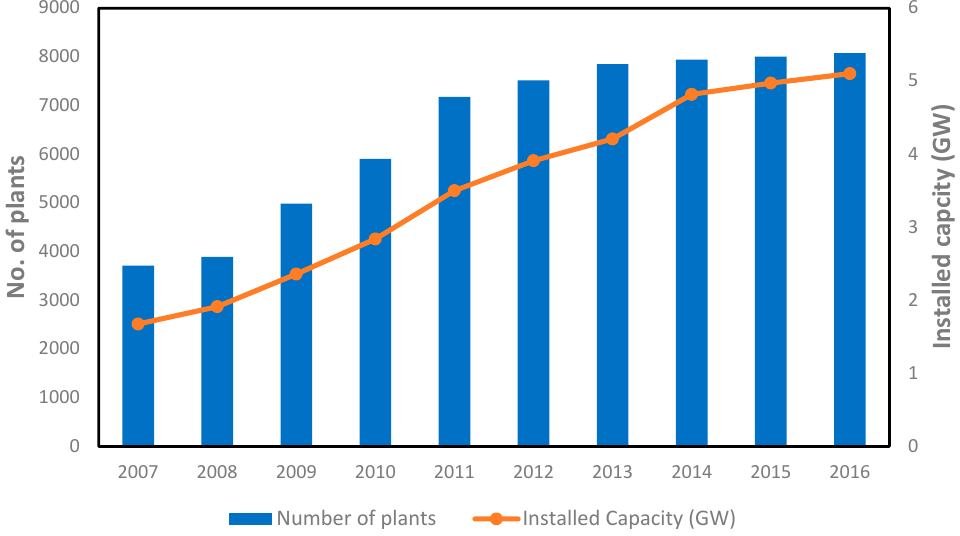
Figure 2. Details of biogas plants in Germany at the end of 2016 Figure 2 . Details of biogas plants in Germany at the end of 2016 [85,87]. Figure 2 . Details of biogas plants in Germany at the end of 2016 [85,87].